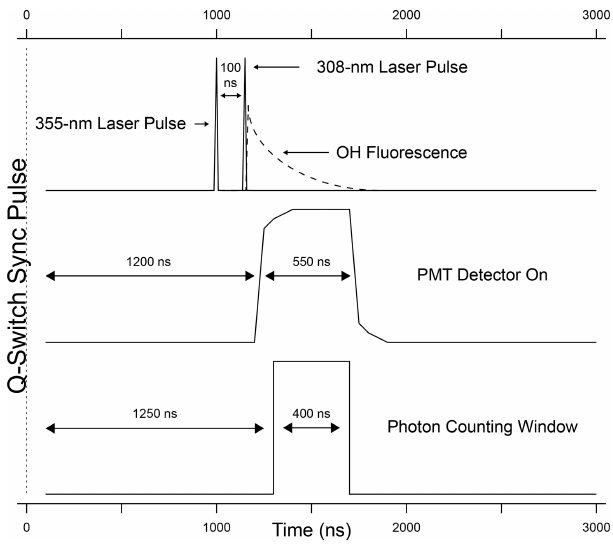
Figure 3. Timing schematic depicting one photofragmenta- tion/excitation/detection cycle.